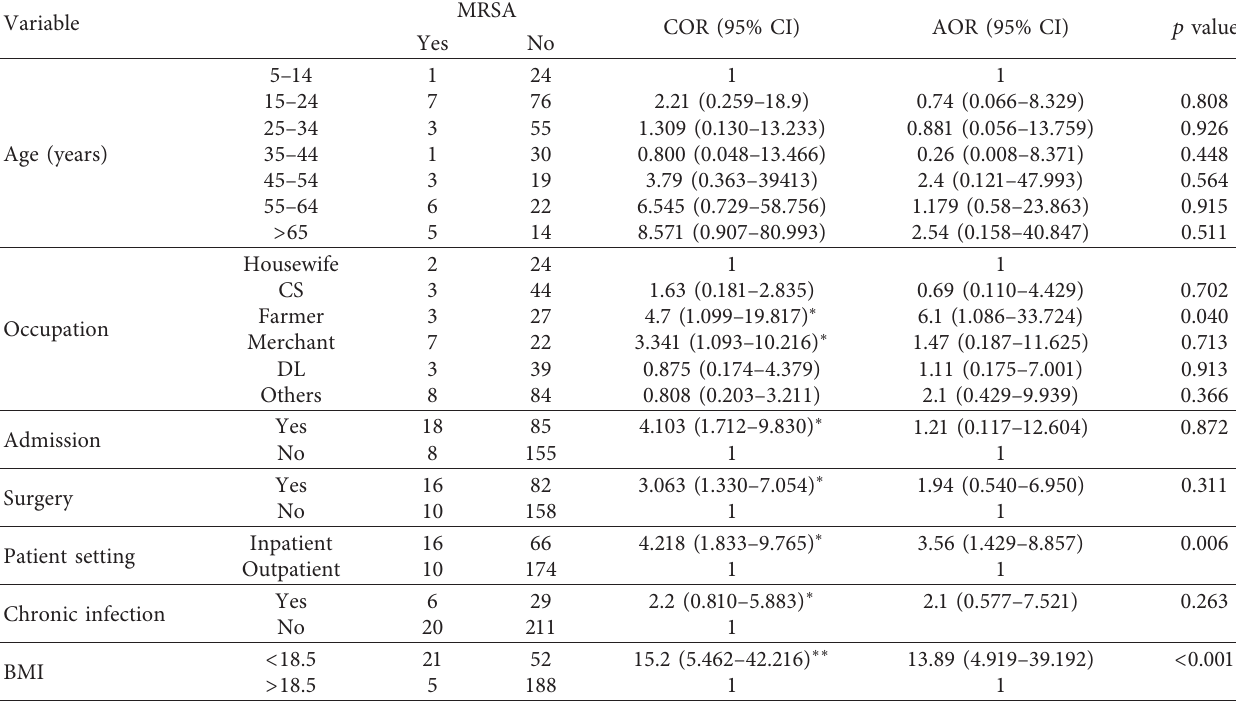
Table 4: Bivariate and multivariate analysis of factors associated with MRSA among patients with wound infection at Dessie Referral